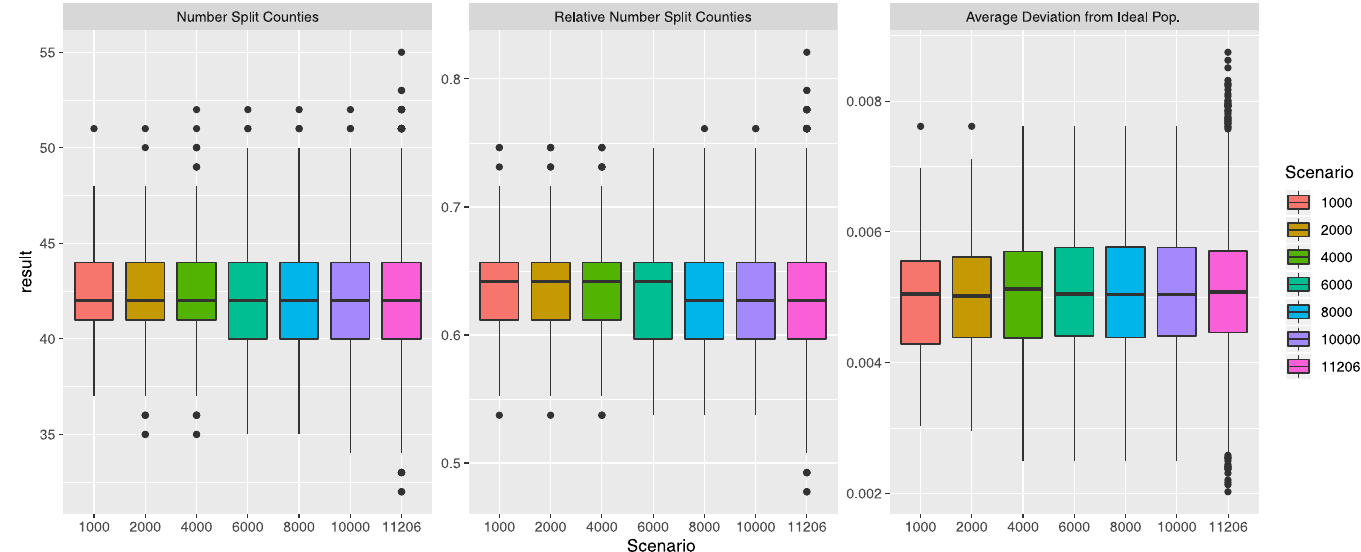
Fig 6. Absolute and relative number of counties split and average deviation from ideal population for different number of solutions.